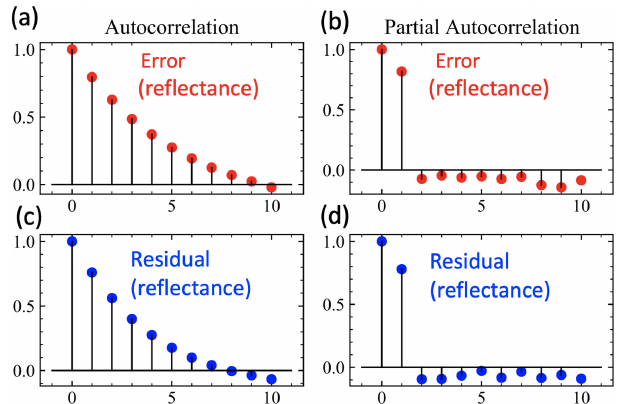
Figure 3. The autocorrelation and partial autocorrelation on the 1000 sets of simulated errors with a correlation angle of 60 ◦ and its corresponding fitting residuals as shown in Fig. 2b and d for the 670nm band. The maximum value in the curve is normalized to 1. The horizontal axis indicates the angular step k as defined in Eq. (13). The Bartlett confidence interval on white noise is not shown due to its small value.